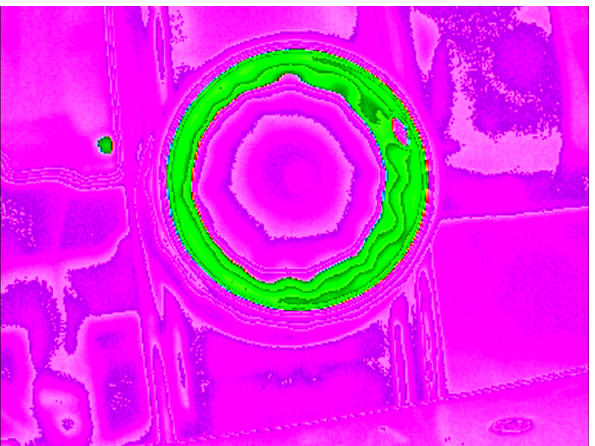
Figure 3. Example of thermal image showing the sealing process done right. In this infrared color scheme, hot locations are represented by the green color while the purple color represents the background environment temperature. The green circle represents the hot area where the seal adhered to the bottle